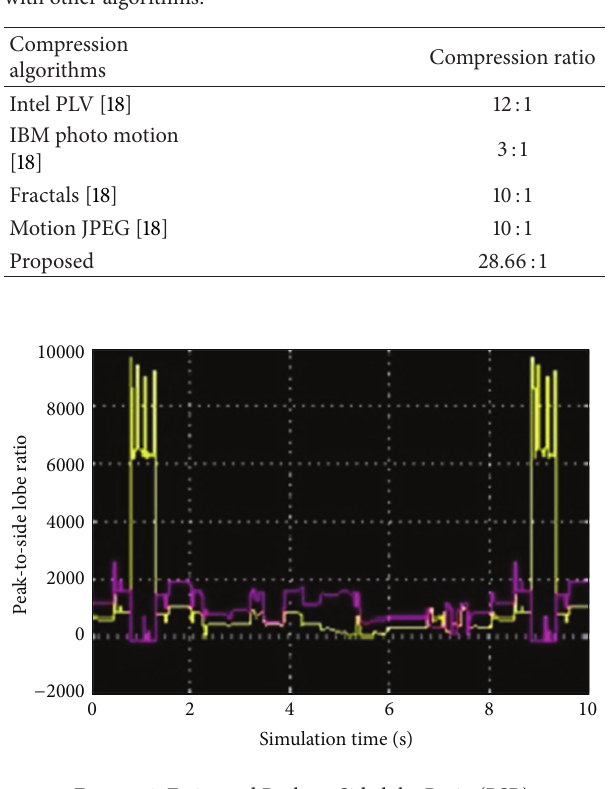
Figure 4: Estimated Peak-to-Side lobe Ratio (PSR).